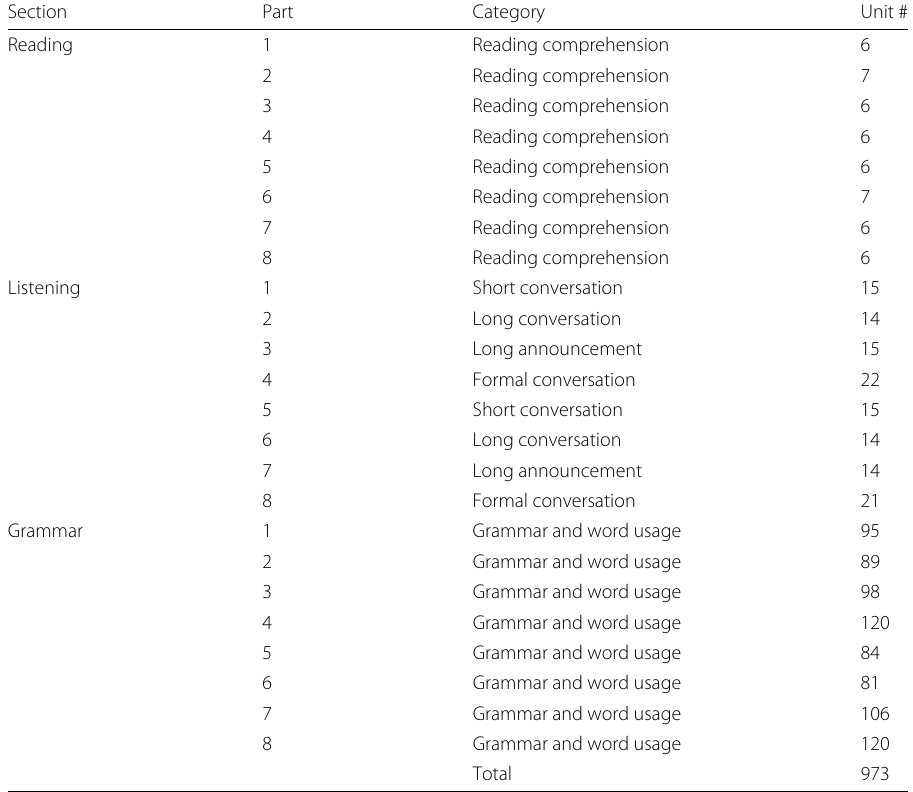
Table 2 Categories and unit numbers of learning materials